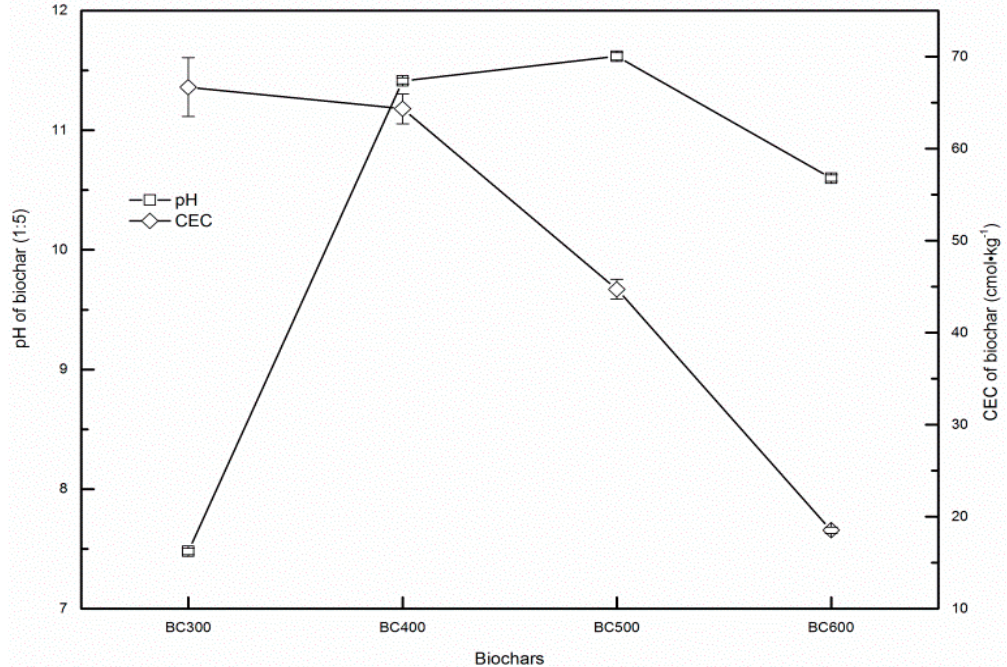
Figure 2. The pH and cation exchange capacity (CEC) of biochars produced at different temperatures. Individual points are averages ( n = 3) and error bars are standard deviations.